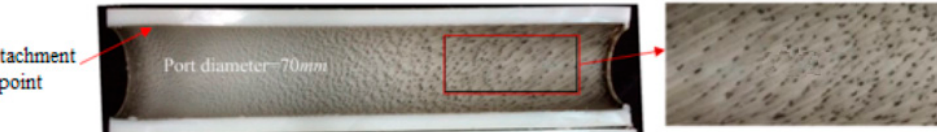
Figure 13. Internal surface of solid fuel after combustion.